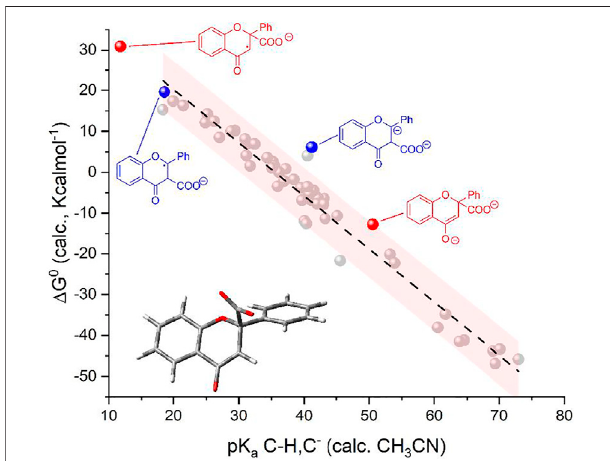
FIGURE 3 | Plot of calculated standard free energy of carboxylation ( Δ G 0 1 ) vs. calculated pK a of the CH/C − couples. Red dots indicate fl avone derivatives upon carboxylation in the β position; blue dots indicate fl avone derivatives upon carboxylation in the α position. The carboxylation product in β starting from F(RA) is unstable during the calculation and explodes releasing CO 2 : in this case, the Δ G 0 value is extrapolated by the linear correlations among the 50 organic substrates. Inset: optimized geometry of the carboxylated product in β starting from F(DA) . The light gray dots indicate the 50 organic molecules reported in Chart 1 and plotted in Figure 1